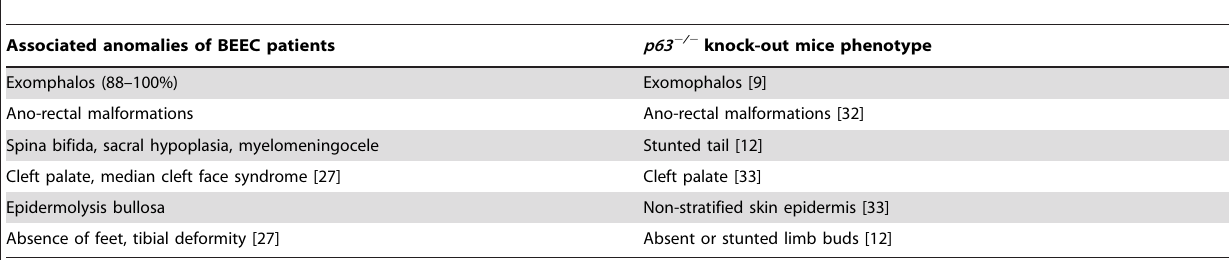
Table 8. The associated anomalies of BEEC patients compared with the p63 2 / 2 mouse phenotype.